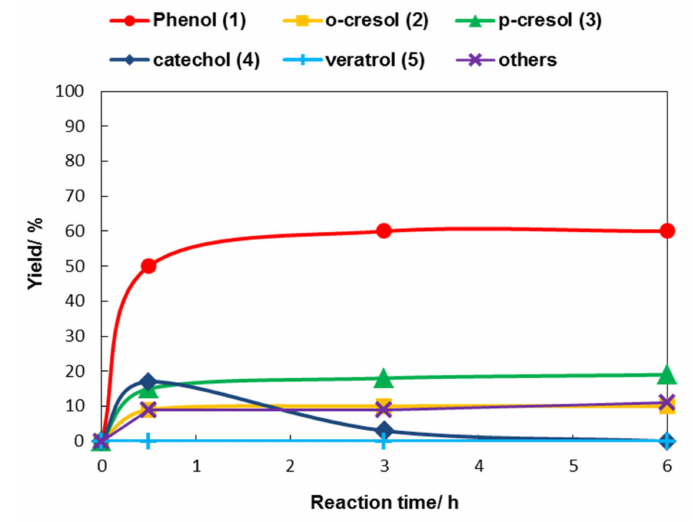
Figure 8. HDO of GUA over BCR catalyst at various reaction